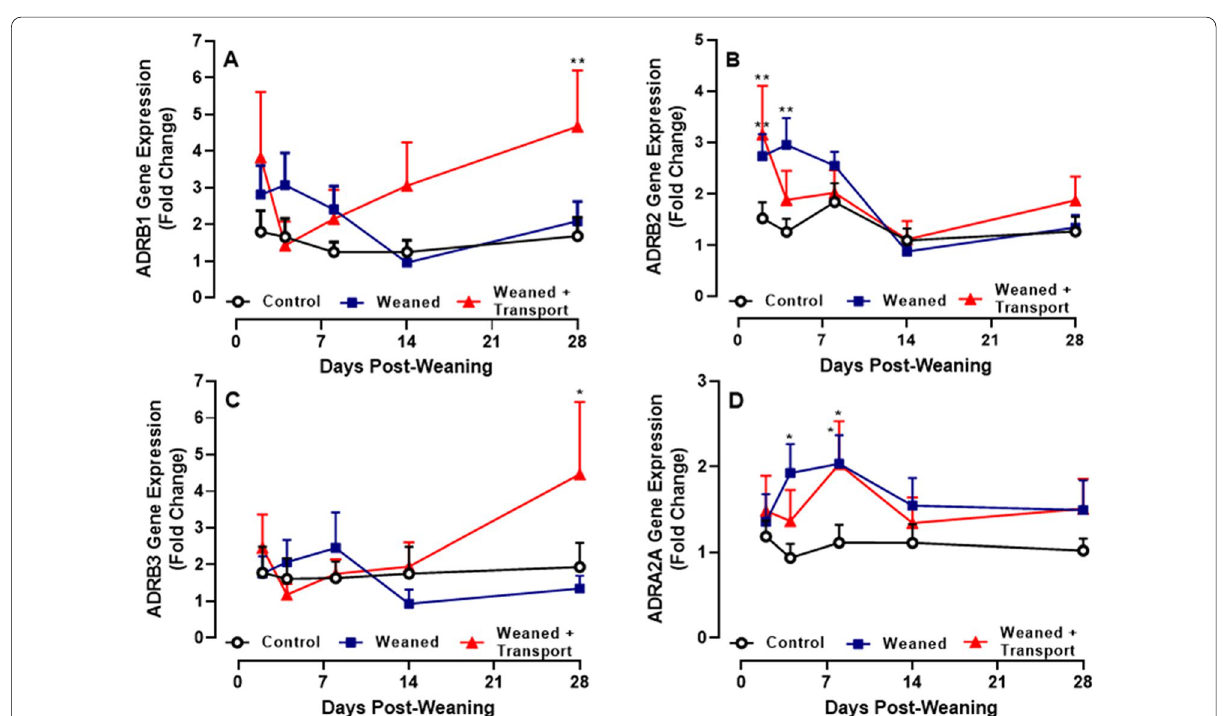
Fig. 1 Analysis of adrenergic receptor gene expression in blood leukocytes of suckling calves (control), suckling calves separated from their dams (Weaned), and weaned and transported (Weaned Transport) calves. Gene expression was quantified with RT‑PCR and data are expressed + as fold change relative to Day 0 (prior to weaning). Gene expression was analyzed for 6 alpha‑ and 3 beta‑adrenergic receptors (ADR) and data presented are for those ADR genes where significant differences were observed when using a one‑way ANOVA to compare Weaned (n 10) and = Weaned Transport groups (n 10) to time‑matched samples from the control group (n 10). Data presented are the mean and 1 SD * p < 0.05; + = = ** p <